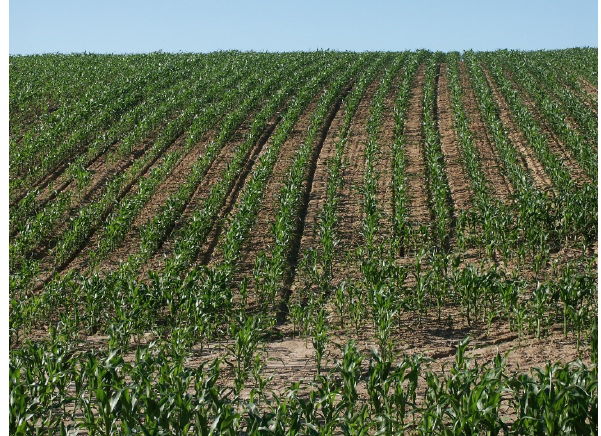
Figure 1. The presence of a dense network of rills and of significant deposition at the footslope (here in Huldenberg, Belgium, in July 2006) is as such sufficient proof for excessive soil erosion (in this case erosion exceeded 100tha − 1 in a single